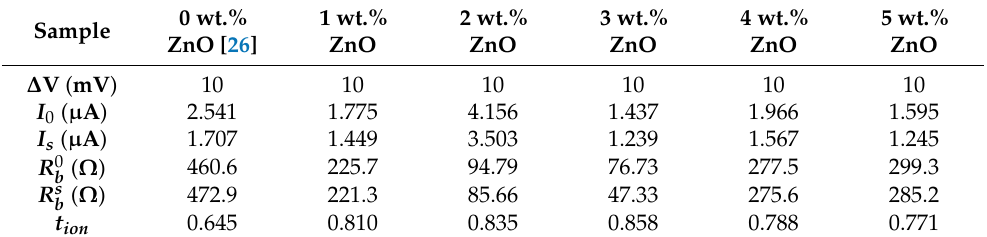
, and R s ) for calculating t ion of the b b